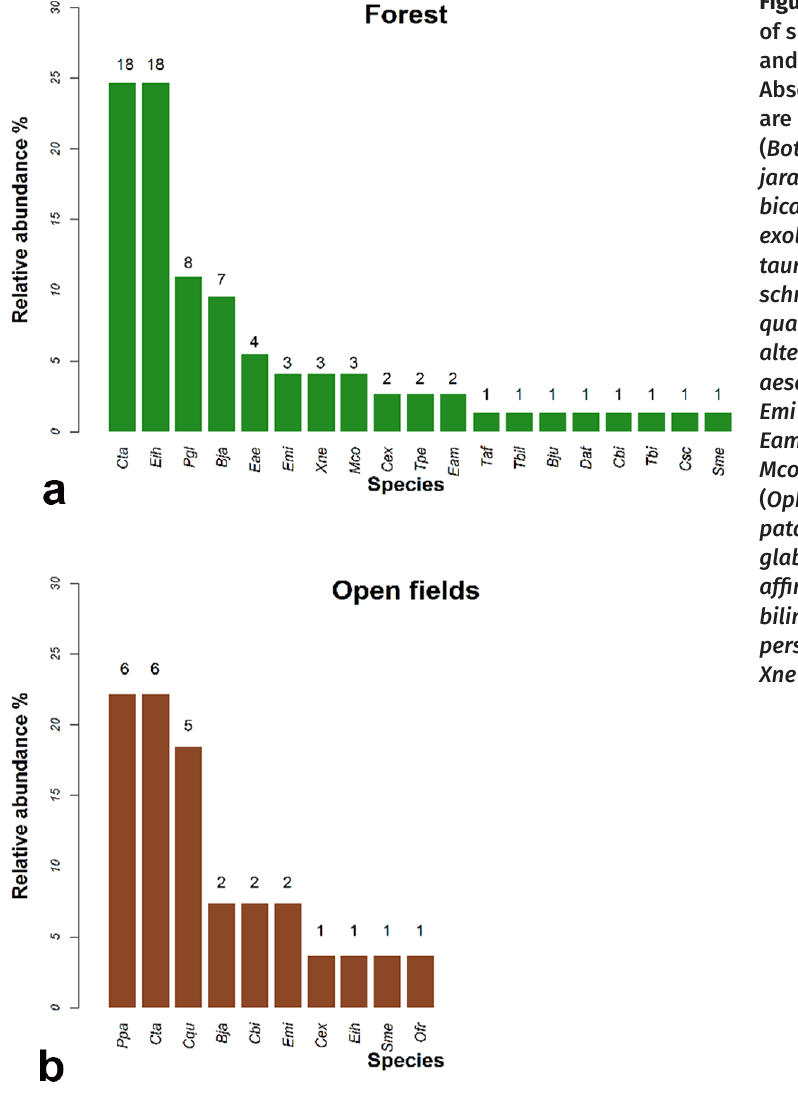
Figure 3. Relative abundance (%) of species sampled in forest (a) and open field (b) physiognomies. Absolute values for each species are shown above each bar.